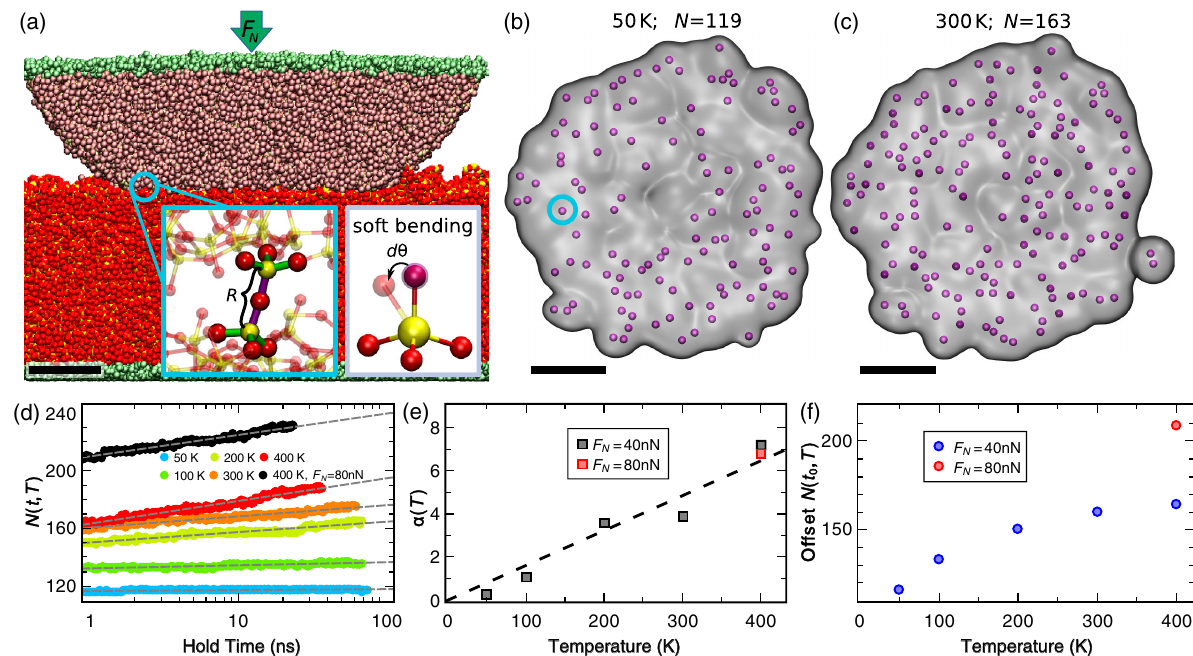
FIG. 3. MD simulations of SiO 2 contact aging under an applied normal load F N . Tip-surface atomic representation after (a) 75 ns of indentation in the MD simulation performed at 50 K with a normal load of F N ¼ 40 nN. The O and Si atoms are, respectively, represented in red and yellow van der Waals spheres. The insets in (a) correspond to a representative siloxane bridge, i.e., Si ─ O ─ Si, between the tip and surface (cyan box) and a representation of a soft [44] angle deformation in such contact that could account for the small contact stiffness measured. (b),(c) In purple we represent the atoms from the tip bonded to surface atoms after 70 ns of simulation at two different temperatures, i.e., 50 and 300 K. The corresponding temperatures and number of bonds ( N ) are shown. With a gray surface we represent the area of the tip at a distance smaller than 3 Å from the surface. (d) Logarithmic time evolution of the total number of bonds — N ð t; T Þ — between the tip and the surface obtained at different temperatures T . Here we are considering in the count both Si ─ O and O ─ O bonds; for further details on the criteria for bond formation, see Appendix E. All curves were obtained from simulations performed at F N ¼ 40 nN, with exception of the black curve where we used F N ¼ 80 nN. In dark gray we represent the logarithmic fit, i.e., N ð t; T Þ ¼ α ð T Þ ln ð t=t 0 Þ þ N 0 ð T Þ , to each of the datasets. (e) Temperature dependence of the slopes, i.e., α ð T Þ , describing the temporal evolution of the bonds formed in the contact as shown in (c). Note that for F N ¼ 80 nN we represented the data point in coral. (f) Temperature dependence of the initial bond concentrations, i.e., N ð t 0 ¼ 1 ns ; T Þ . Again, the data point obtained for F N ¼ 80 nN is represented in coral. The scale bar in all images corresponds to a distance of 3